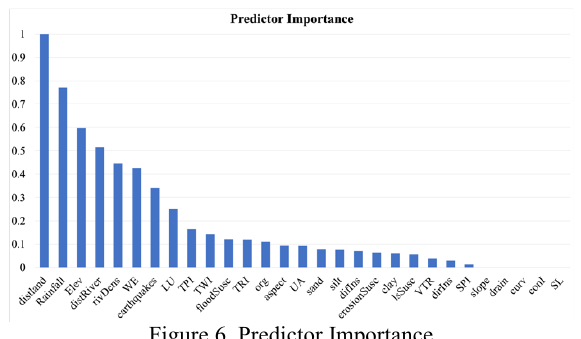
Figure 6. Predictor